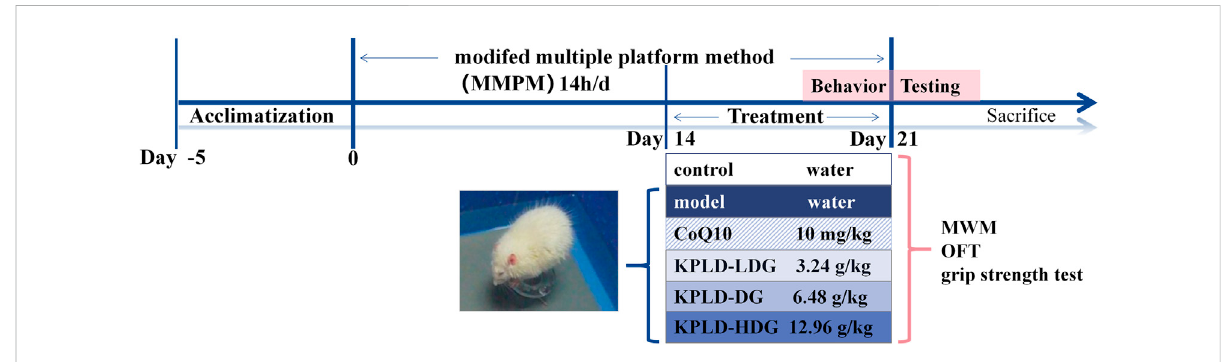
FIGURE 1 Experimental procedure and drug administration